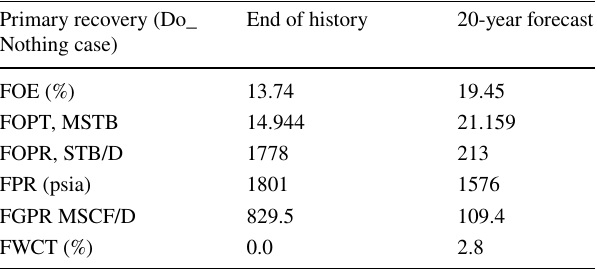
Fig. 6 a Primary recovery forecast for FOE, FOPT and FOPR; b primary recovery forecast of FPR, FGPR, and FWCT Table 8 ‎ Primary recovery forecast of S3